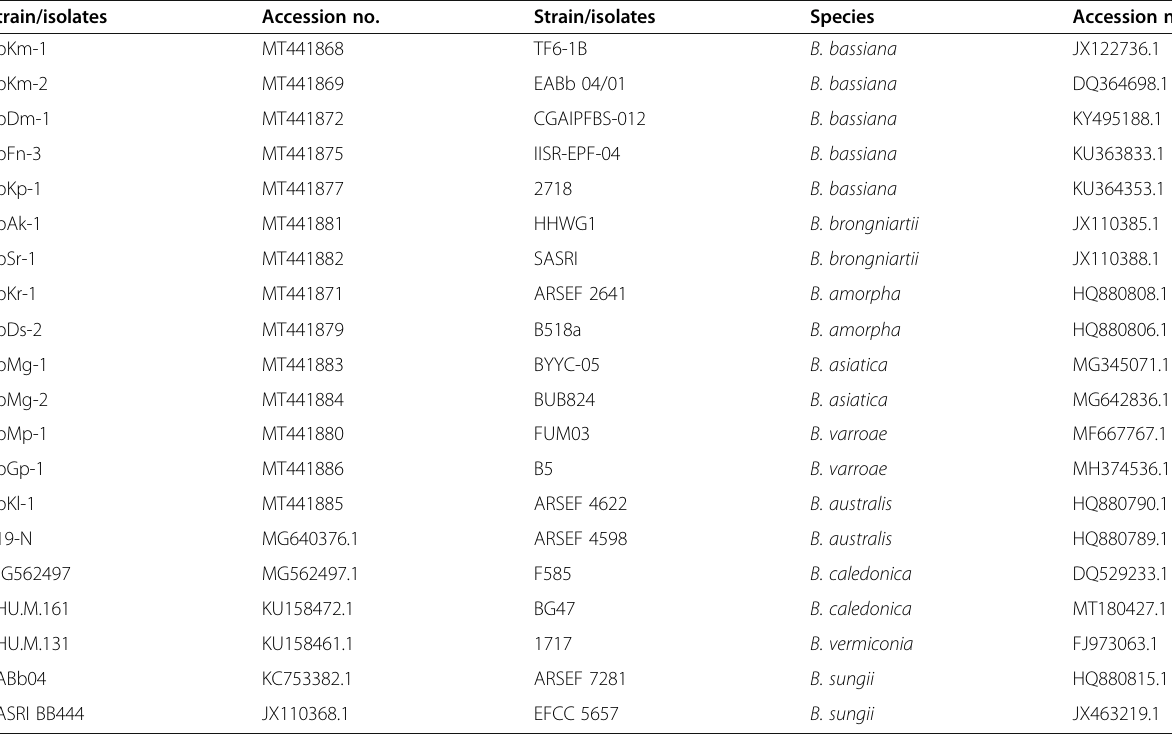
Table 6 GenBank nucleotide accessions of tested Beauveria bassiana isolates along with other Beauveria species based on ITS region used for phylogenetic analysis